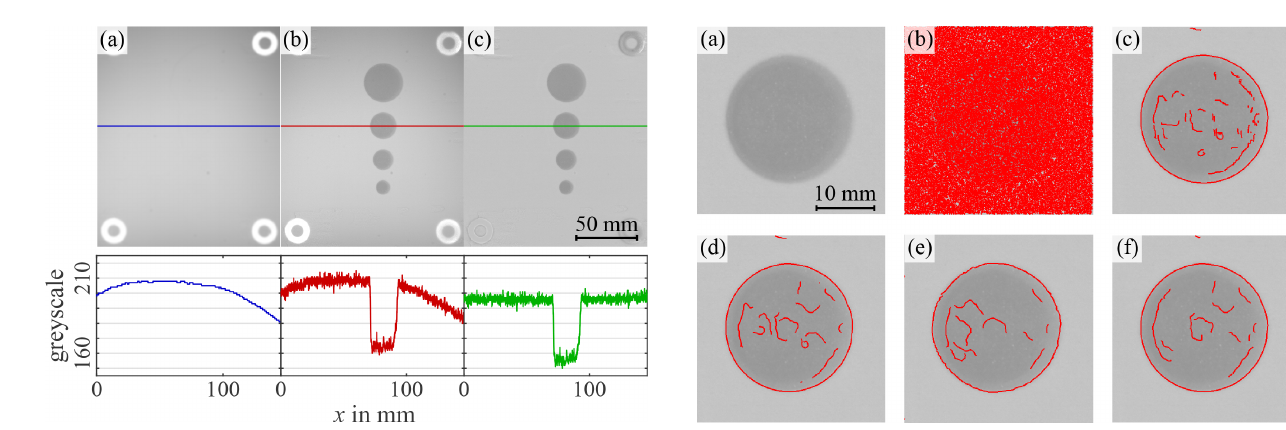
Figure 8. Analysis of influence of different filters on contour detec- tion: (a) original section of melting pool to be segmented, (b) with- out low-pass filtering, (c) 2-D Gaussian filtering, (d) 1-D Gaussian filtering, (e) 1-D Gaussian regression filtering, and (f) 1-D spline